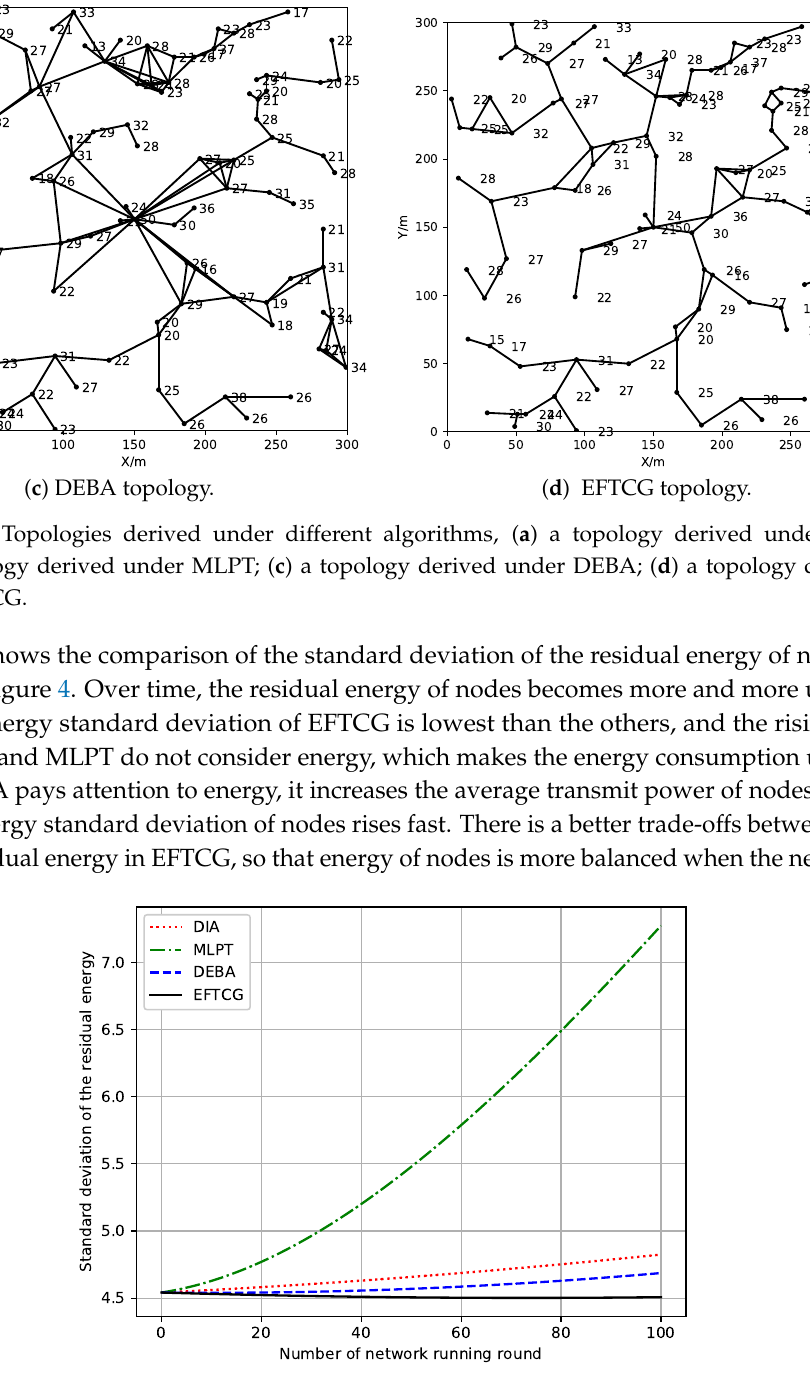
Figure 5. The comparison of standard deviation of the residual energy under different